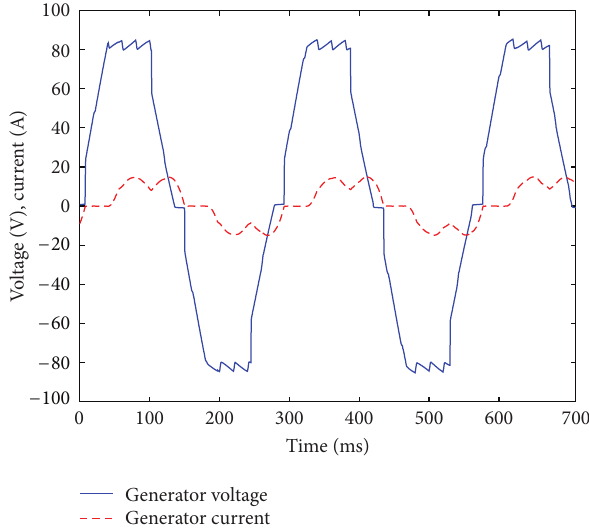
Figure 9: Generator voltage (line-to-line) and current while main- taining a 10.5% duty cycle.